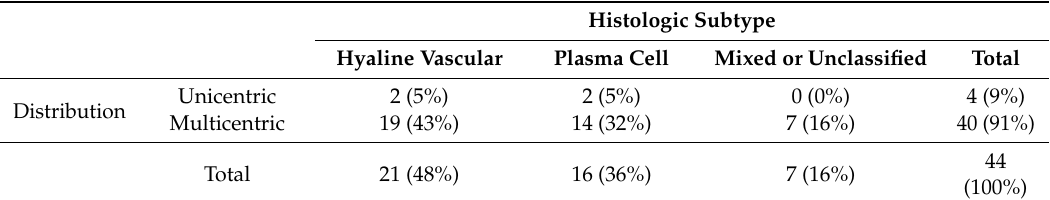
Table 1. Nodal distribution and histologic subtypes of patients with Castleman disease (CD).